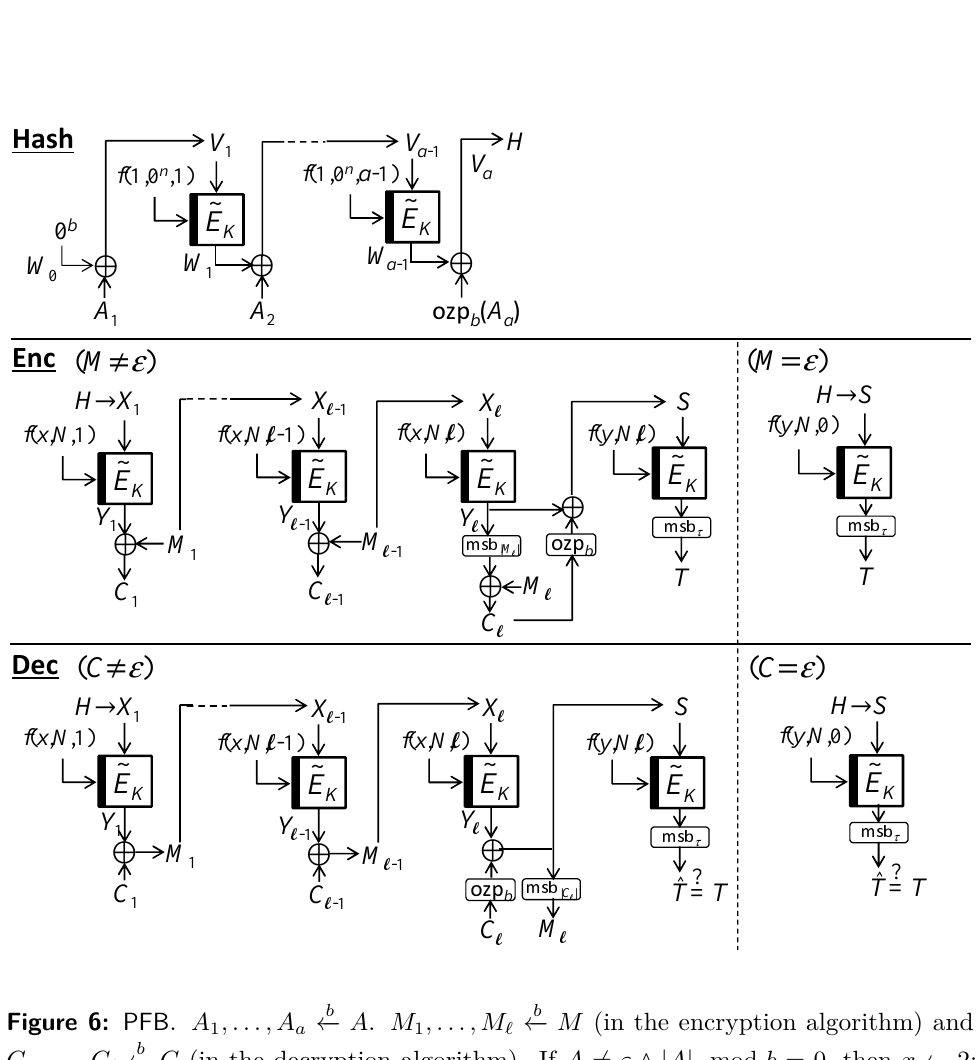
Figure 6: PFB . A 1 , . . . , A a b ←− A . M 1 , . . . , M ‘ b ←− M (in the encryption algorithm)